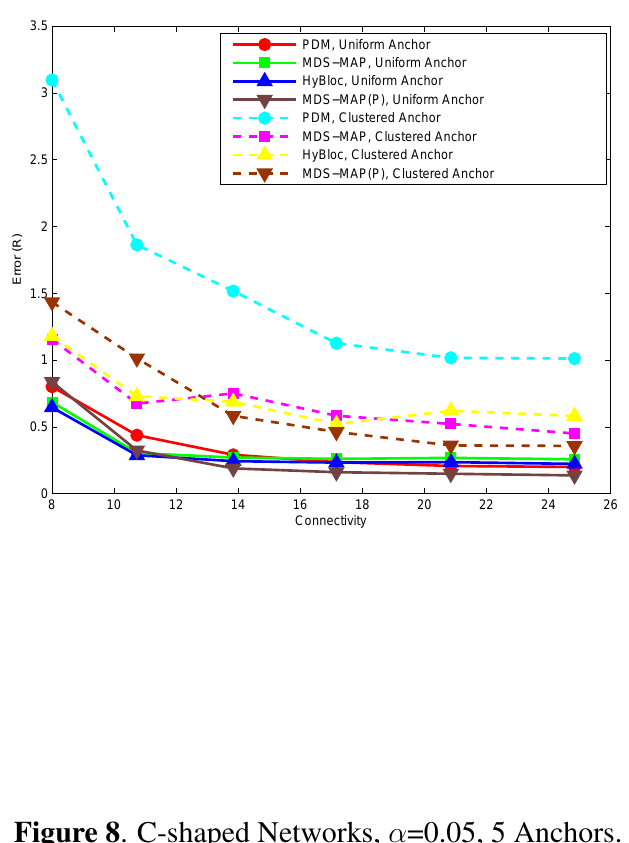
Figure 7 . Uniform Networks, α =0.10, 5 Anchors.